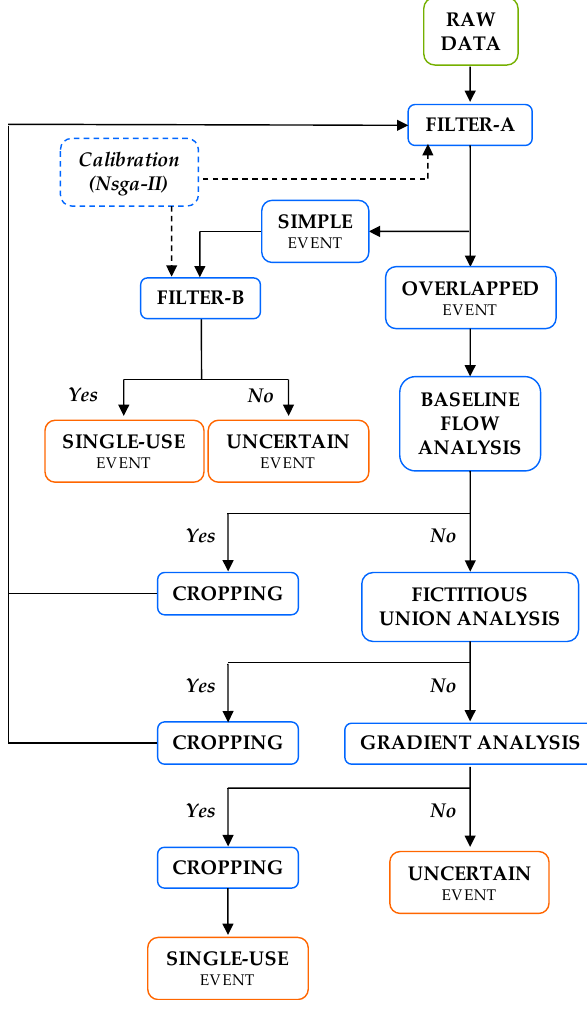
Figure 2. Flow chart of the disaggregation process and sorting of events as single ‐ use or uncertain .